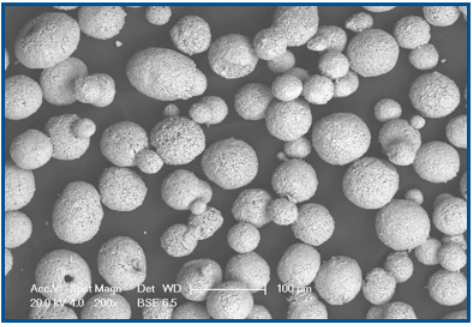
Figure 2. Microstructure of YSZ coating powder.